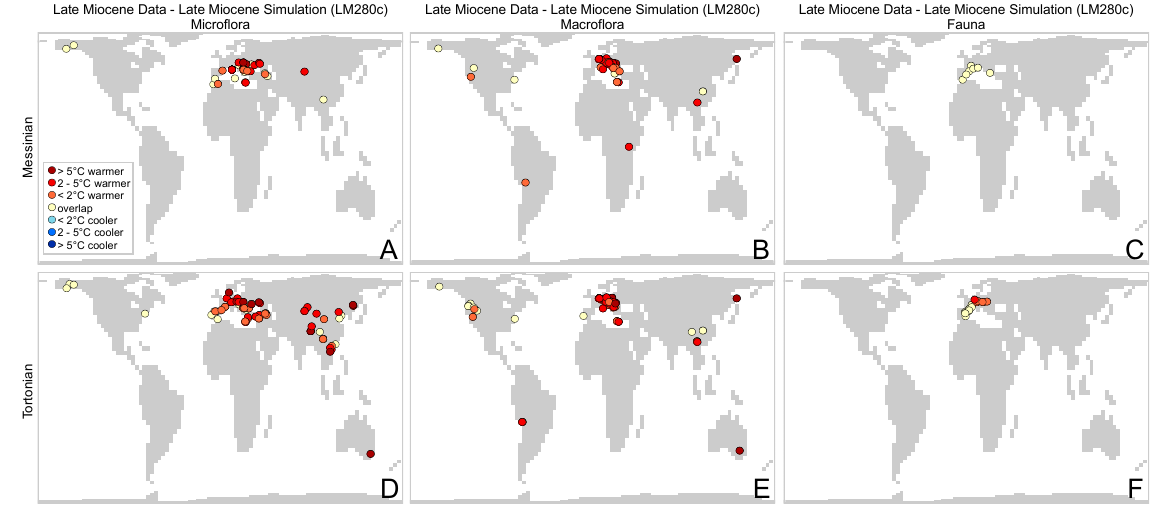
Fig. 8. Results from the model–data comparison for mean annual temperature, late Miocene data–LM280c.